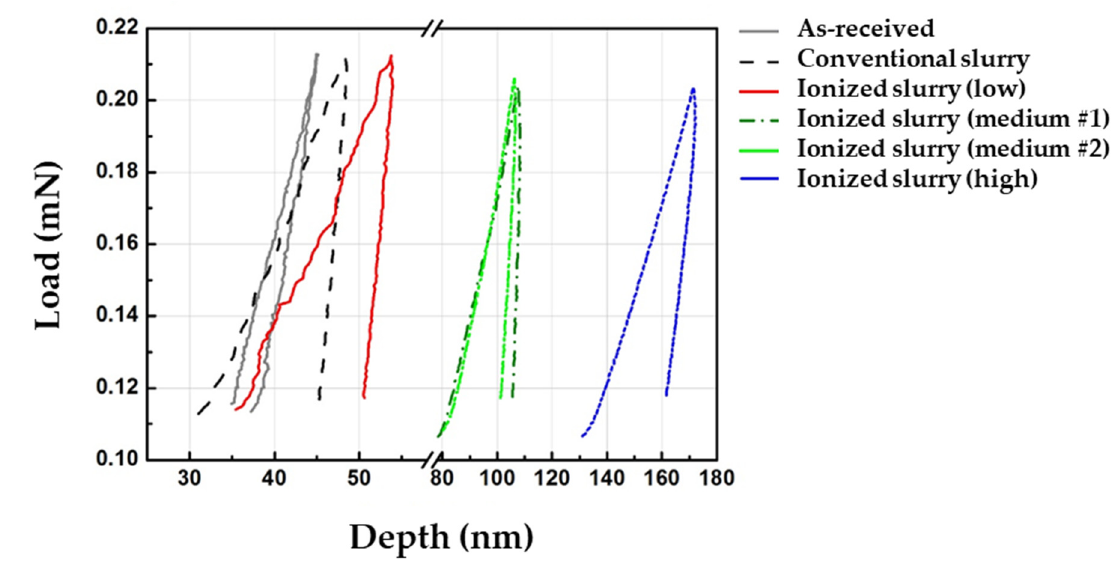
Figure 13. Load-indentation depth curves for surfaces etched by slurries with different AC power strengths. The indenta- tion occurred at a maximum load of 0.2 mN.